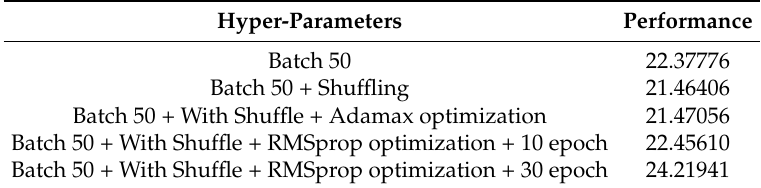
Table 6. Model improvement